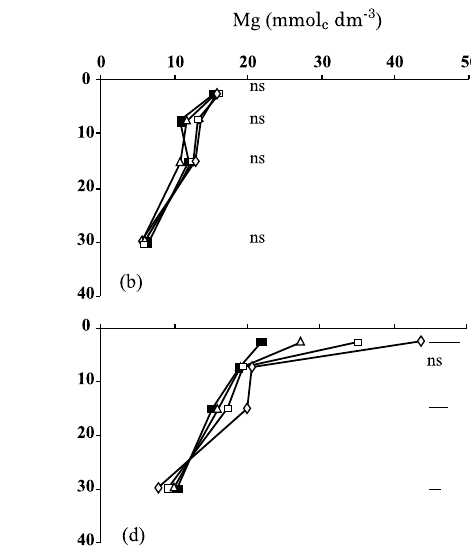
Figure 7. Magnesium levels in the soil profile as affected by nitrogen fertilization ( ): 0; ( ): 50; ( ΔΔ ΔΔ Δ ): 100 and ( ): 150 kg ha -1 of N, 18 months after liming ((a): 0; (b): 1500; (c): 3000 and (d): 6000 kg ha -1 of lime). least significant difference at 5 % by the t test. ns: non